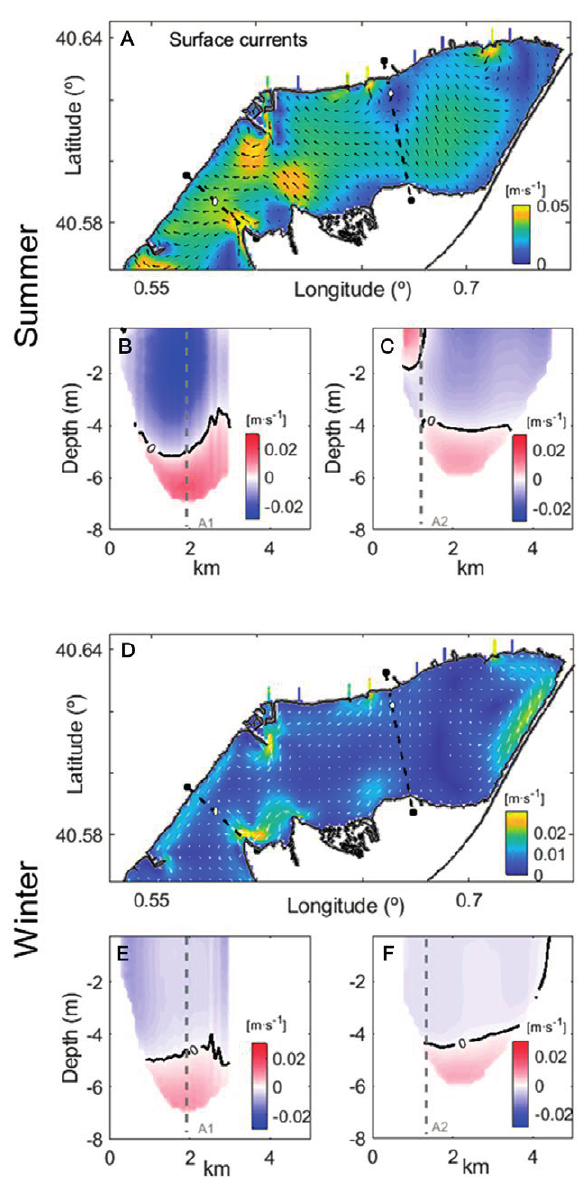
Fig 9. – Top images (A and D) show the modelling results for the average circulation in summer 2013 (A) and winter 2014 (D). Flows across the black dashed sections (A and D) are plotted in images B and C for summer, and E and F for winter. Locations of the ADCP moorings are shown with grey